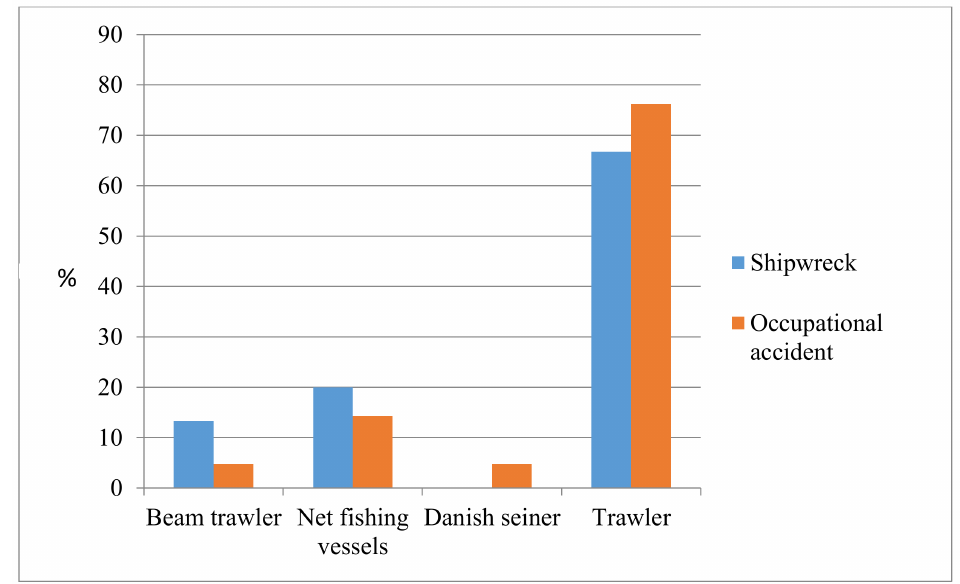
Figure 4. Distribution of different kinds of fishing vessels involved in shipwrecks and occupational injuries in percentage in the period